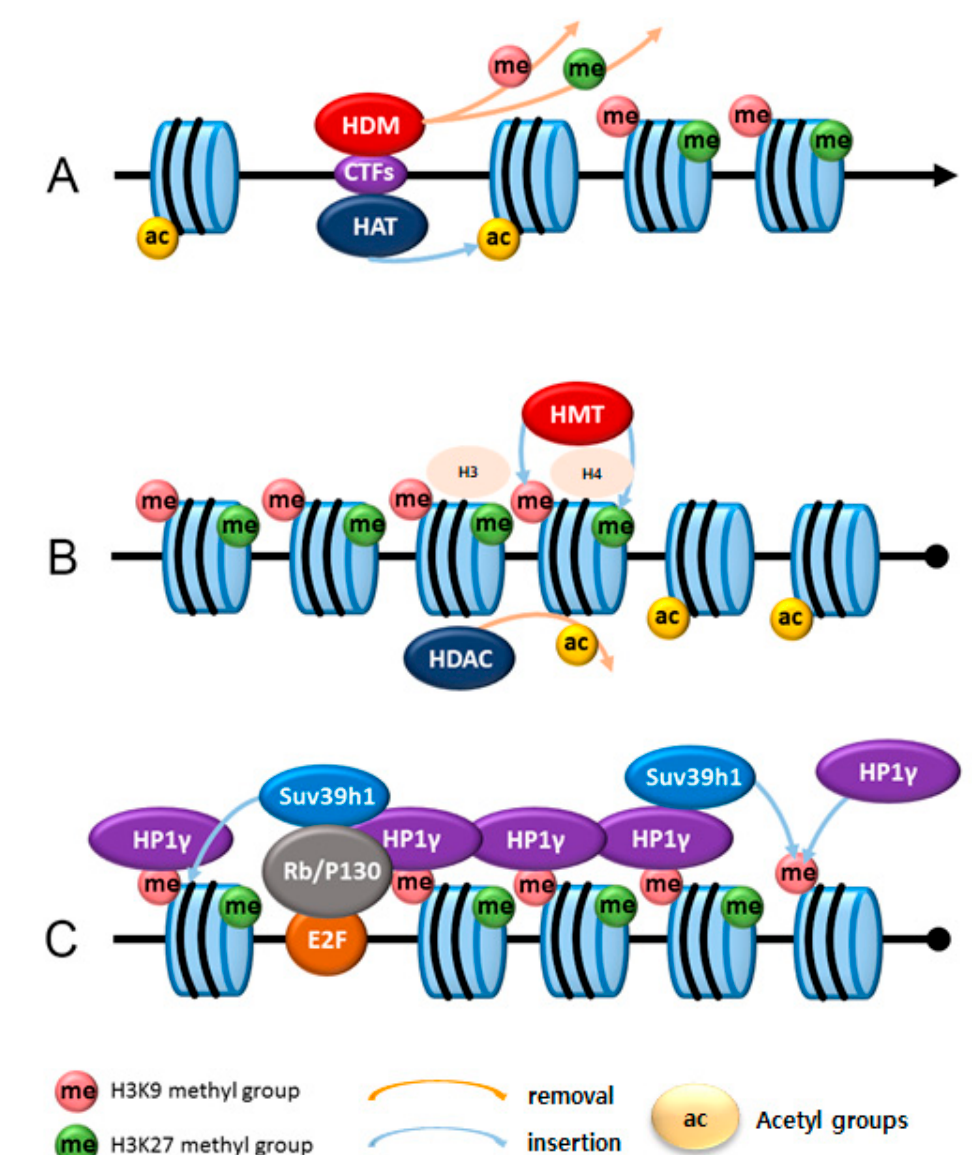
Figure 3. Model of epigenetic gene regulation in cardiomyocytes. ( A ) Activation of cardiac-specific genes: cardiac-specific transcription factors (CTFs) activate cardiac-specific genes by recruiting transferring of acetyl groups to histone H3 and/or H4 histone using acetyltransferases (HAT). Also, they recruit histone demethylases (HDM) to remove silencing methyl marks from H3K9 and H3K27. ( B ) Silencing of non-cardiac genes: histone deacetylases (HDACs) remove acetyl groups (AC) from H3 and/or H4, and histone methyltransferases (HMT) put methyl groups on H3K9 and H3K27 to suppress and silence non-cardiac genes. ( C ) By recruiting HP1 γ to E2F responsive promoters, Rb directly promotes permanent cell cycle exit that has undergone methylation of H3K9 (modified from [93]).